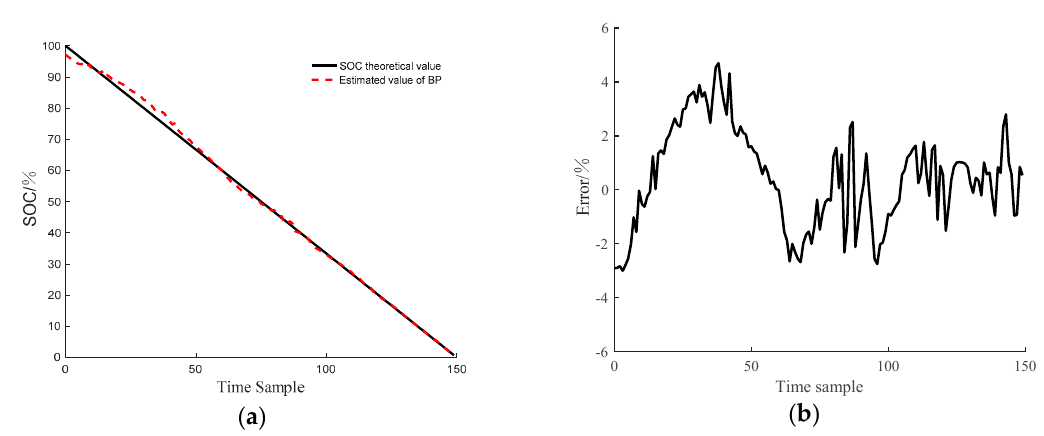
Figure 6. BP network estimation accuracy: ( a ) Comparison curves between SOC estimation and theoretical values; ( b ) the error curves of the estimation methods compared with the theoretical values.